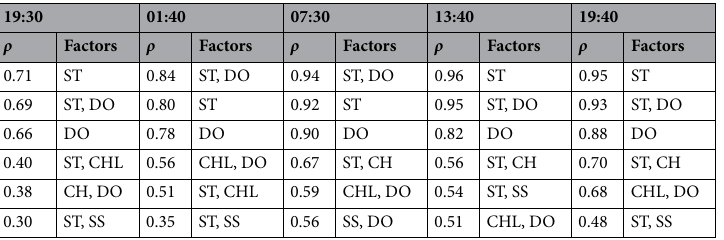
Table 2. Results of BIO-ENV analysis between environmental factors (ST, SS, CHL, and DO) and zooplankton community in the Caroline Seamount area on June 2 to 3, 2019. ρ indicates the Spearman correlation coefficient between zooplankton community and environmental